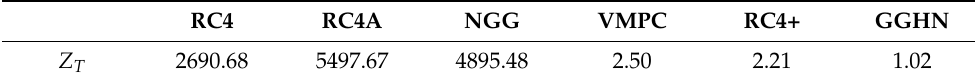
Table 4. Values of Z T for each